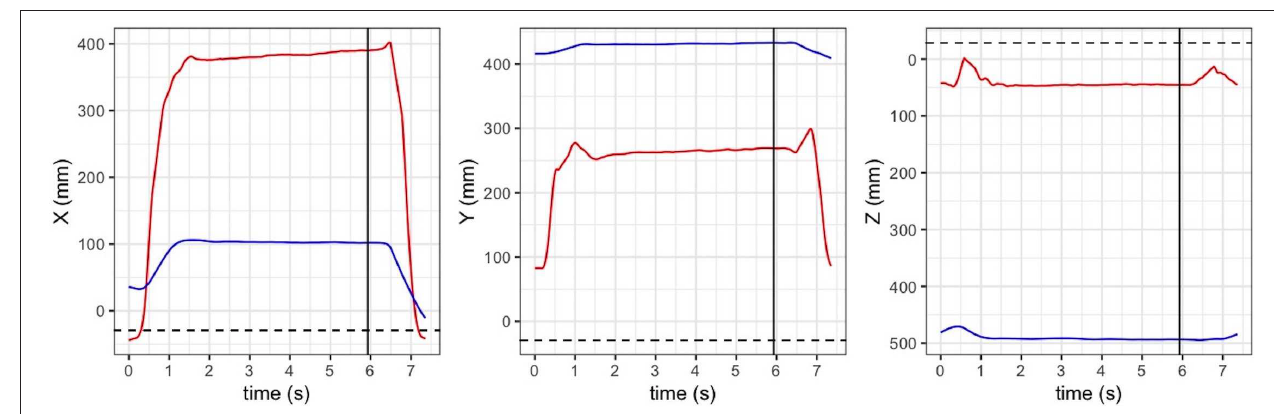
FIGURE 4 | Kinematics data from one observer in one representative trial. Dotted line: Position of the reference marker on the table. Red: Position of the smartphone. Blue: position of the participant’s nose. Higher values signify positions to the right of the marker (x), higher than the marker (y); or farther away from the marker (z). Note the characteristic extended period at near-zero velocity before the moment of selfie taking (solid lines) on all three dimensions.